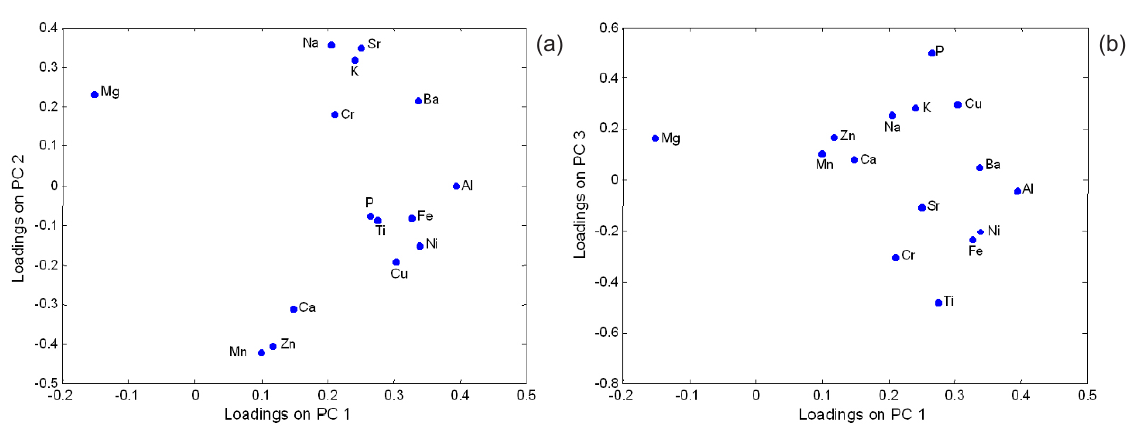
Figure 2. Loading plots – projection of elements on the plane spanned by: (a) PC 1 and PC 2, (b) PC 1 and PC 3.